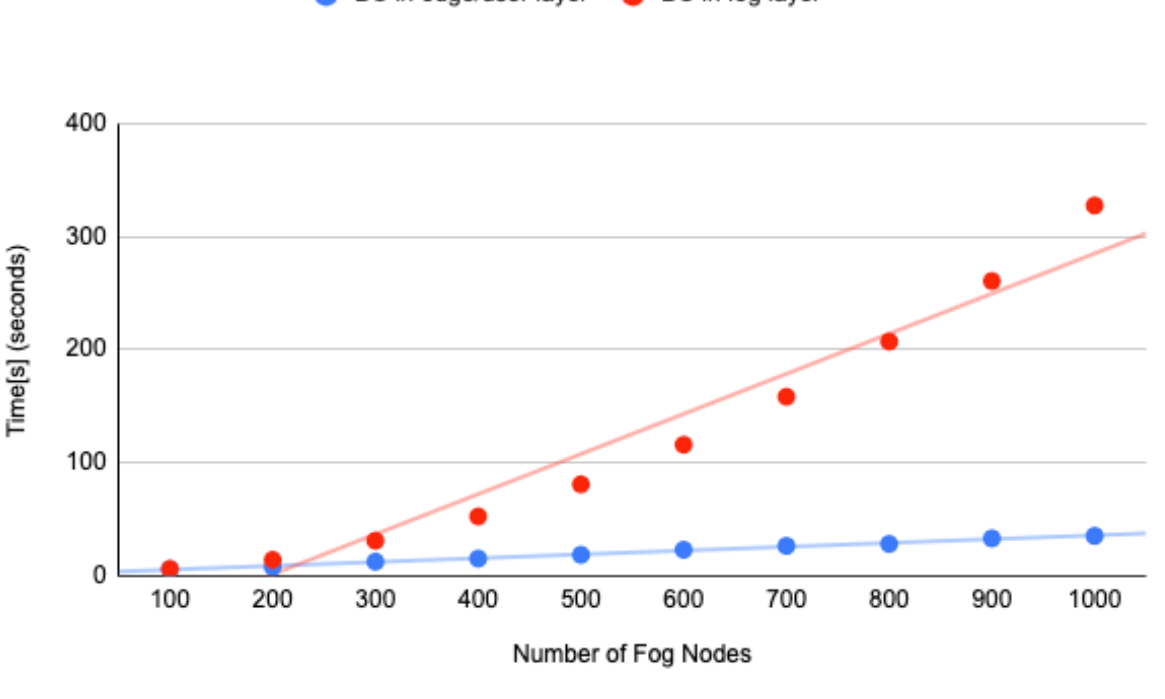
Figure 18. FobSim simulation result. Table 5. FobSim simulation parameter